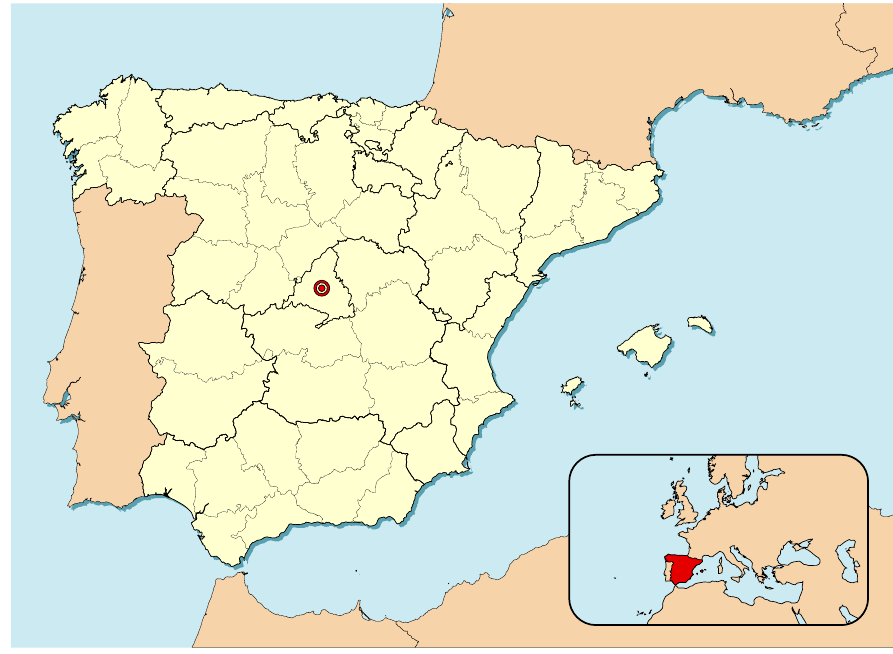
Figure 2. Location of the city of Madrid within